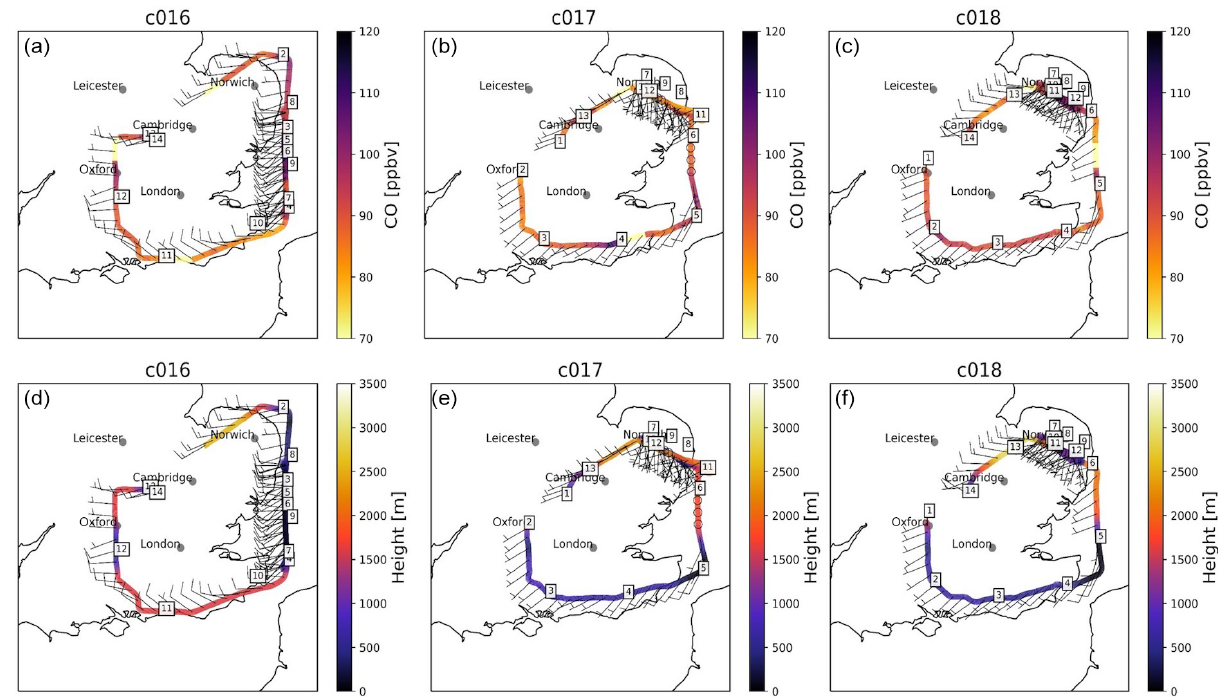
Figure 1. Map of flight paths for all three flights (C016 on Monday 3 July 2017 and C017 and C018 on Tuesday 4 July 2017). Panels (a, b, c) show the concentrations of CO measured on board at (d, e, f) FAAM BAe-146 altitude. Arrows indicate wind speed and direction at 1min intervals along the path. The numbers in boxes correspond to distinct flight segments which are used hereafter to locate FAAM BAe-146 geographically during the